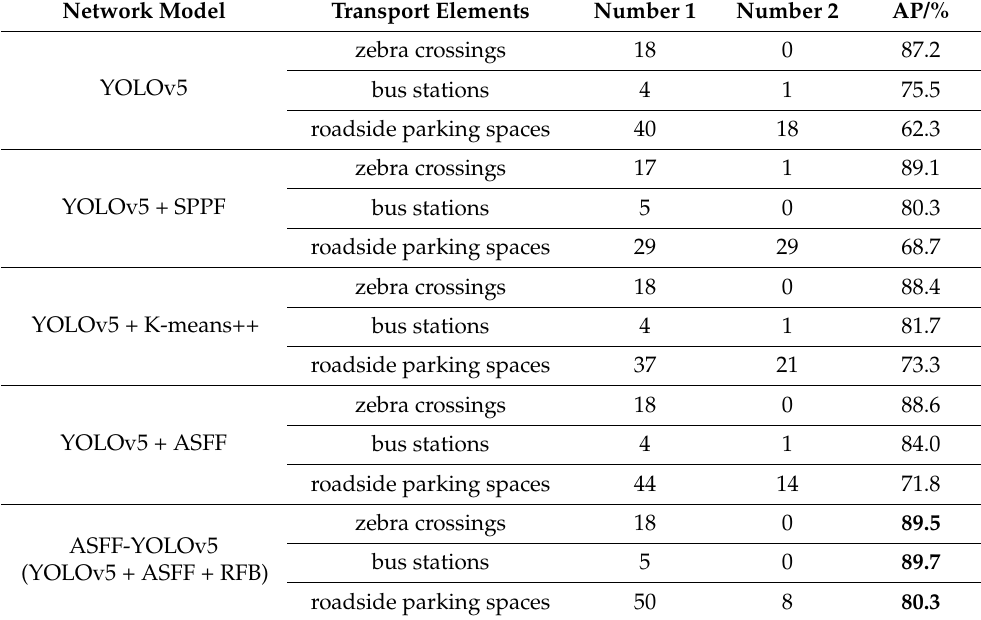
Table 7. Predicted results of ablation experiments for a large and complex